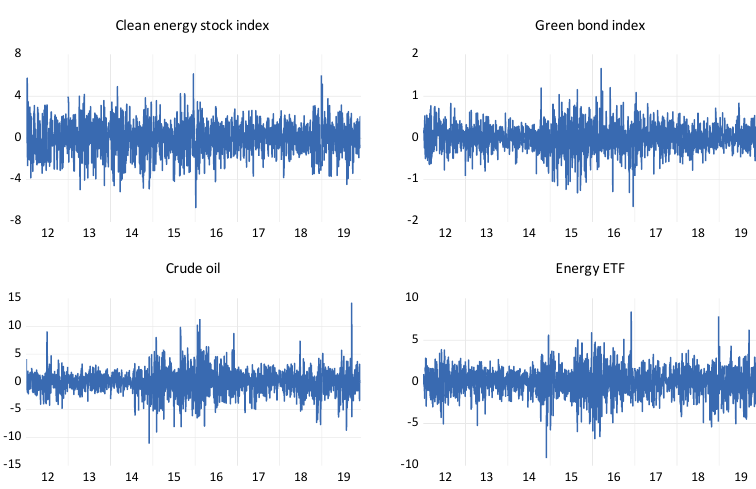
Figure A1. Plots of the levels of the clean/green and dirty energy indices.